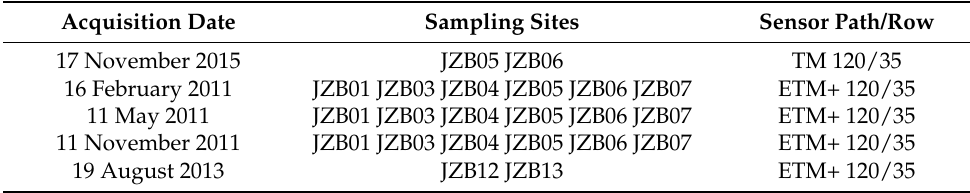
Table 1. Information of Sampling